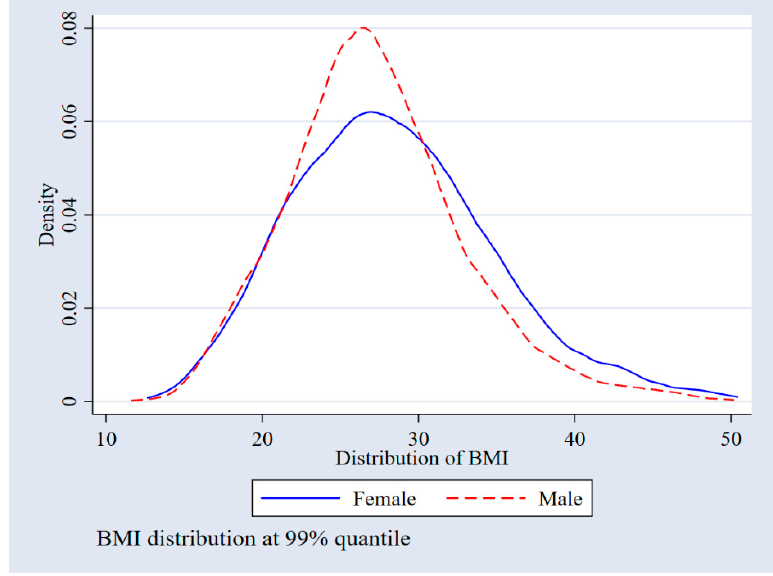
Figure 1. BMI gender distribution. Results from the 2013 Saudi Health Interview Survey (SHIS).